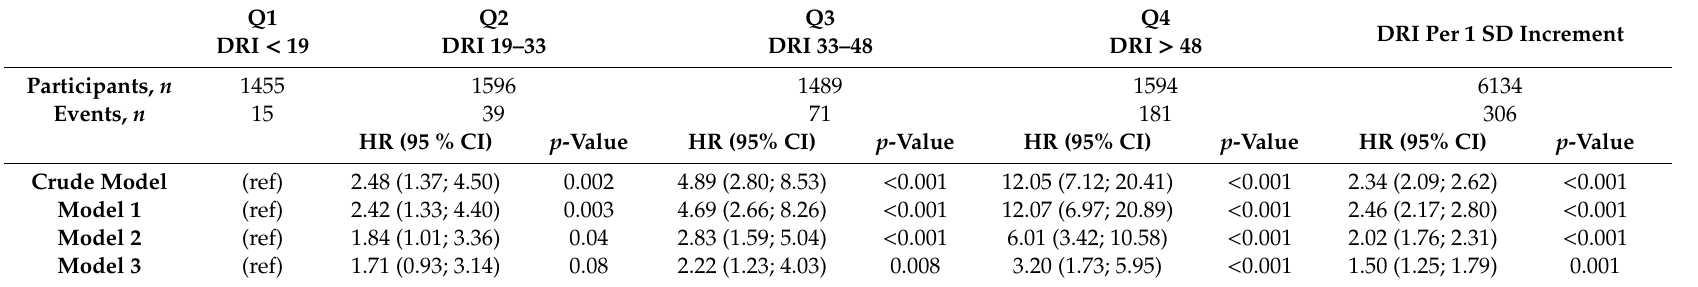
Table 2. Association of DRI scores with incident T2D by quartile in the PREVEND study ( n = 6134).